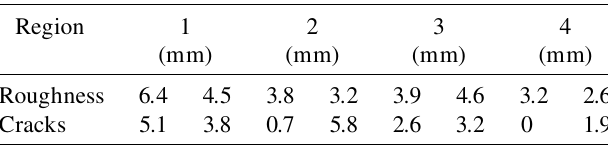
TABLE VII. Widths of regions of surface roughening and cracks for each end cap from the first high-power test. Region